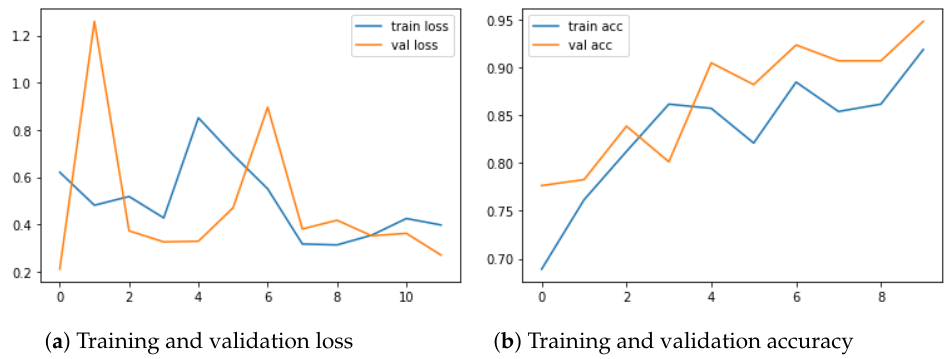
Figure 4. Classification performance of the Inception v3 model on a GPU.